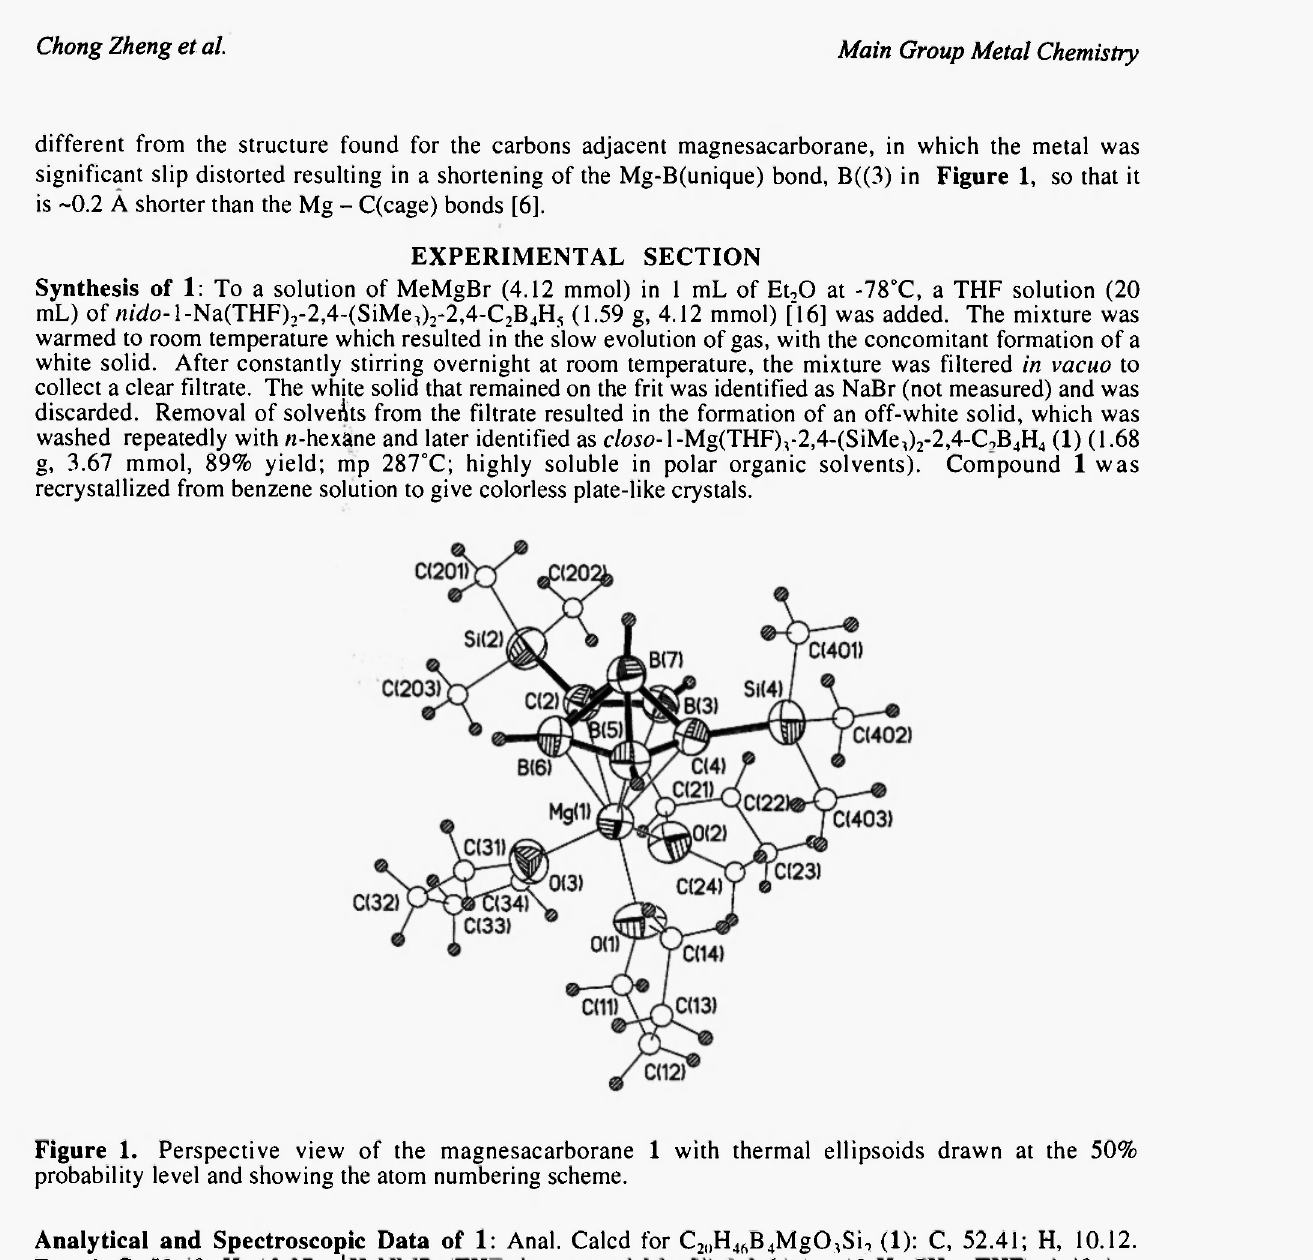
Figure 1. Perspective view of the magnesacarborane 1 with thermal ellipsoids drawn at the 50% probability level and showing the atom numbering